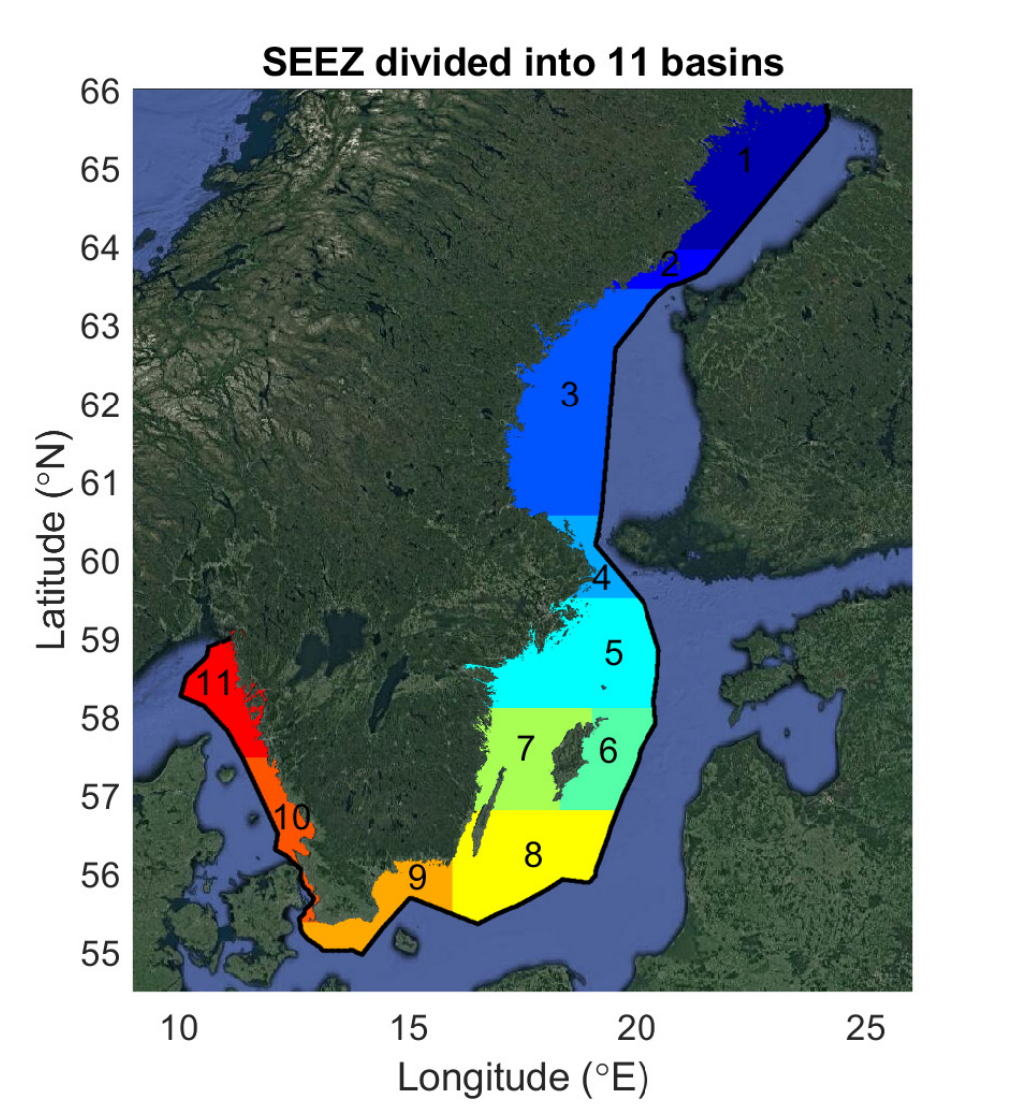
Figure 1. Subdivision of the Swedish Exclusive Economic Zone (SEEZ) into 11 smaller basins indicated by the number and different colors following